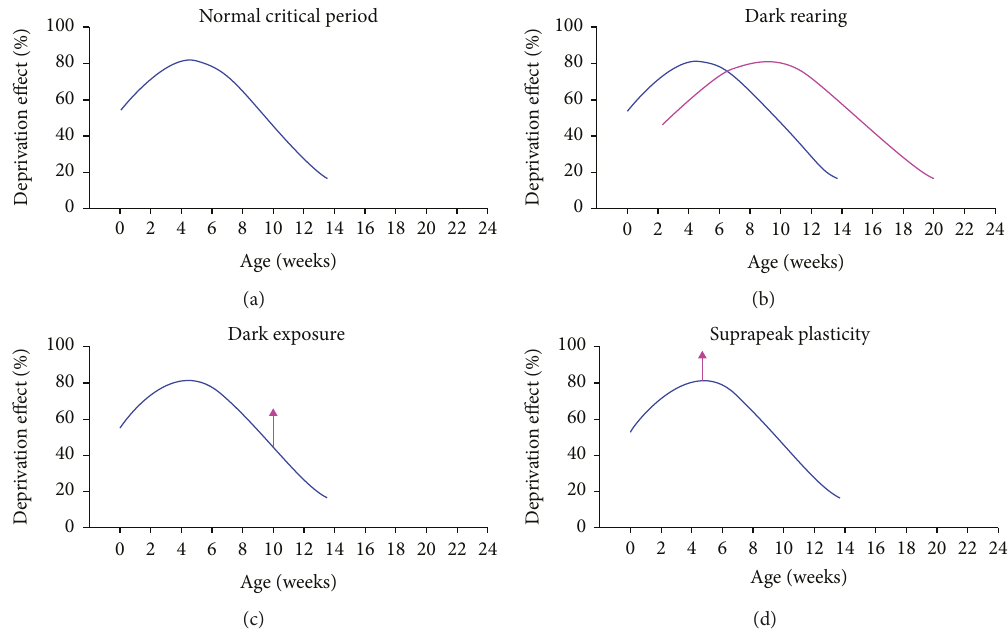
Figure 1: Illustration of the e ff ect on plasticity capacity following immersion in complete darkness. Pro fi le of the critical period in normally reared cats (based on data from [9]) demonstrates peak plasticity at about 4 weeks of age followed by a progressive decline to low levels that are maintained into adolescence (a). Dark rearing from near birth and for long durations has been postulated to slow the overall time course of the critical period (magenta pro fi le in (b)) so that enhanced plasticity can be observed at ages when normally reared animals exhibit lower plasticity capacity (based on [15]). More recently, short durations of darkness (dark exposure) in rodents and cats have been employed to raise plasticity levels beyond that observed from age-matched controls (c). In the current study, we investigated the possibility that 10 days of dark exposure imposed just prior to the critical period peak can enhance plasticity capacity beyond its natural maximum